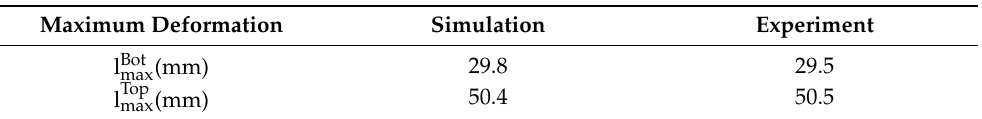
Figure 10. The visual measurement to verifying PC2 using marker tracking. The maximum defor- mations of the spring at the bot pivot and top pivot conditions are shown in the left and right figures. The red coordinates information indicates the position of the spring follower. Table 2. Comparison of simulation and experimental results for the maximum deformation of spring at the top and bottom pivot conditions.